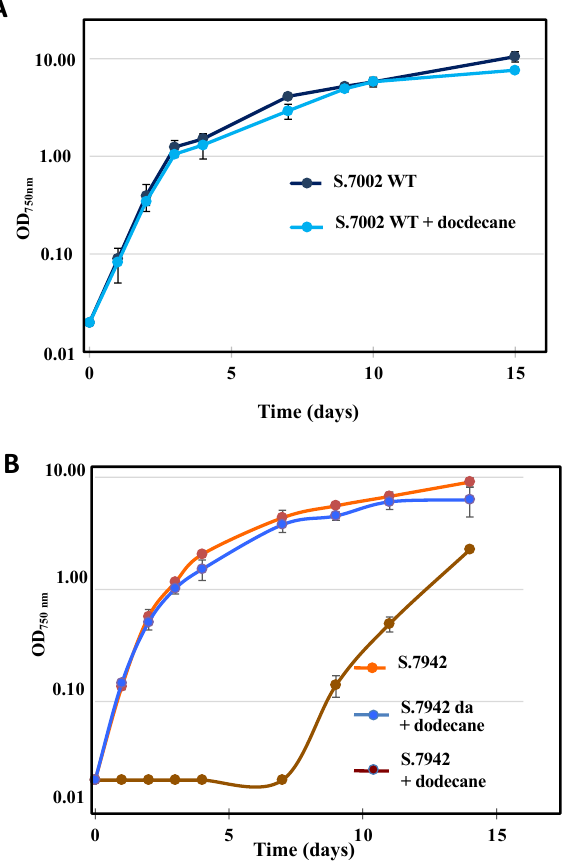
Figure 3. Influence of a dodecane overlay on the photoautotrophic growth of Synechococcus PCC 7002 (S.7002; ( A )) and Synechococcus elongatus PCC 7942 (S.7942; ( B )). Cells were grown photoautotrophically in the absence or presence of a dodecane (20% vol/vol) overlay. S.7942, denoted as da (da for dodecane-adapted cultures), was inoculated with cells that were precultivated under dodecane for more than two weeks. Error bars represent standard deviations from biological triplicates.